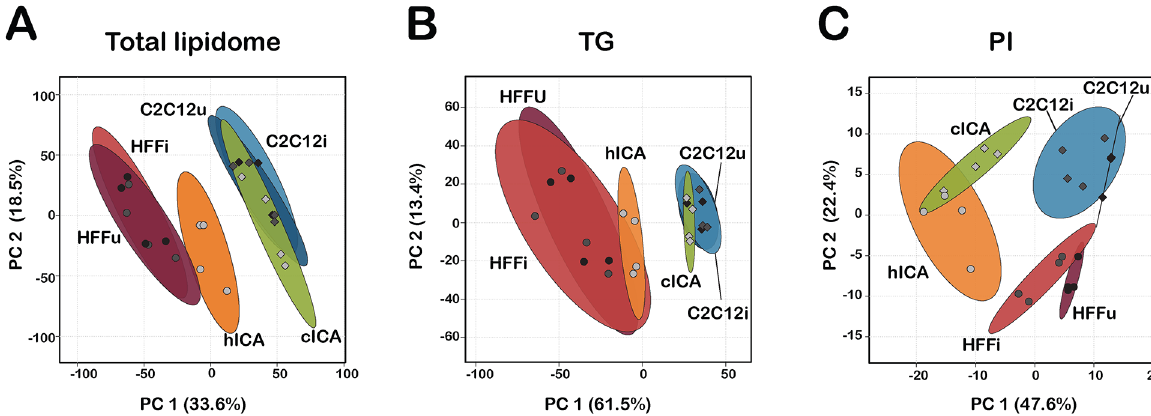
Fig 3. Principle component analysis of host and parasite lipidomes at the lipid species level. Principle component analysis of lipid species are plotted for the (A) total lipidome, (B) TG subclass, and (C) PI subclass. The first two principle components are plotted (PC1 and PC2) with proportion of variance for each component shown in parenthesis. Each sample is represented and the 95% confidence interval indicated in shaded circle.